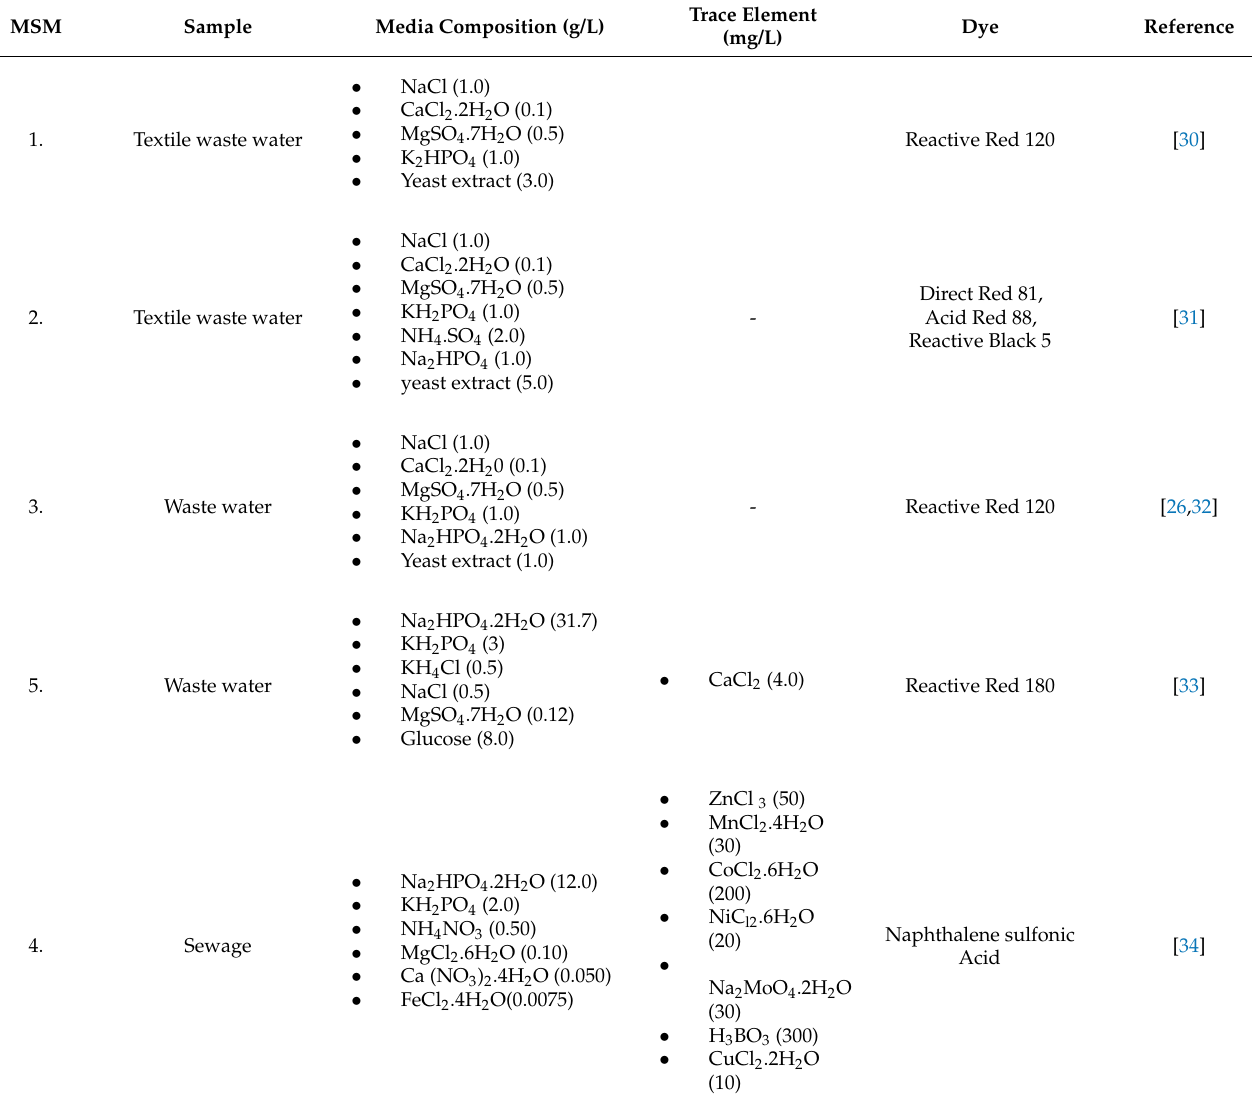
Table 2. Different media composition used for finding suitable dye decolourisation